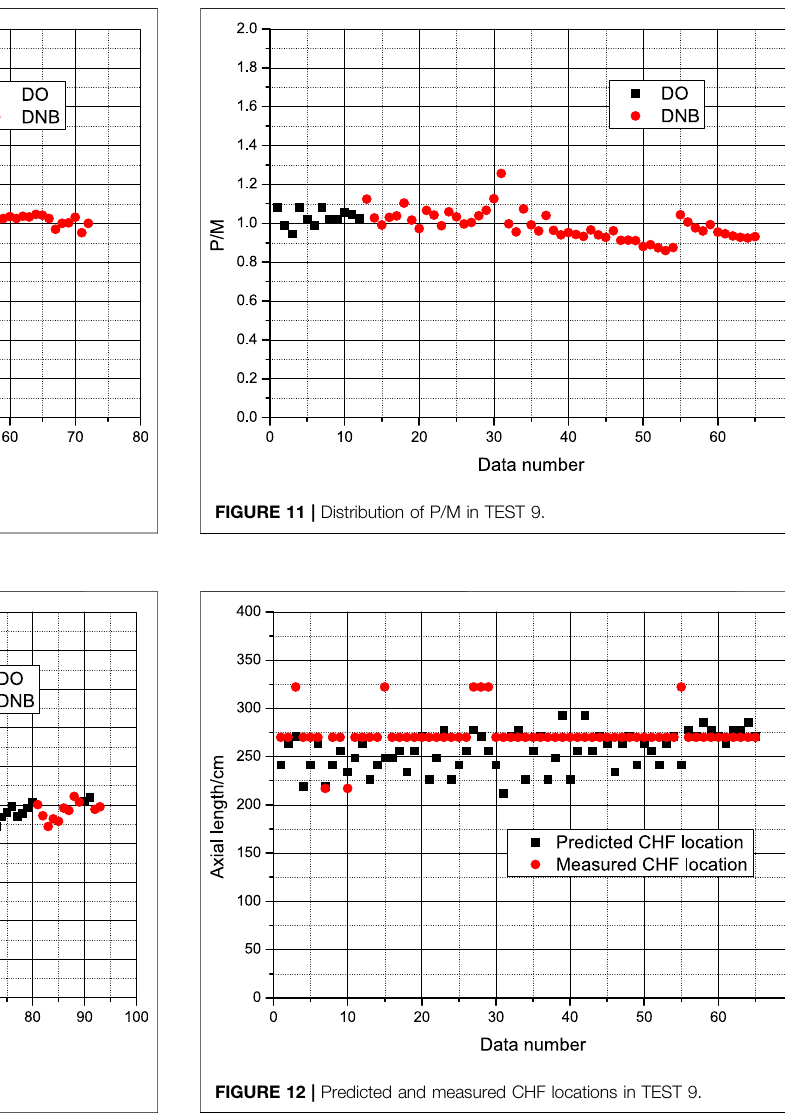
FIGURE 10 | Distribution of P/M in TEST 7.